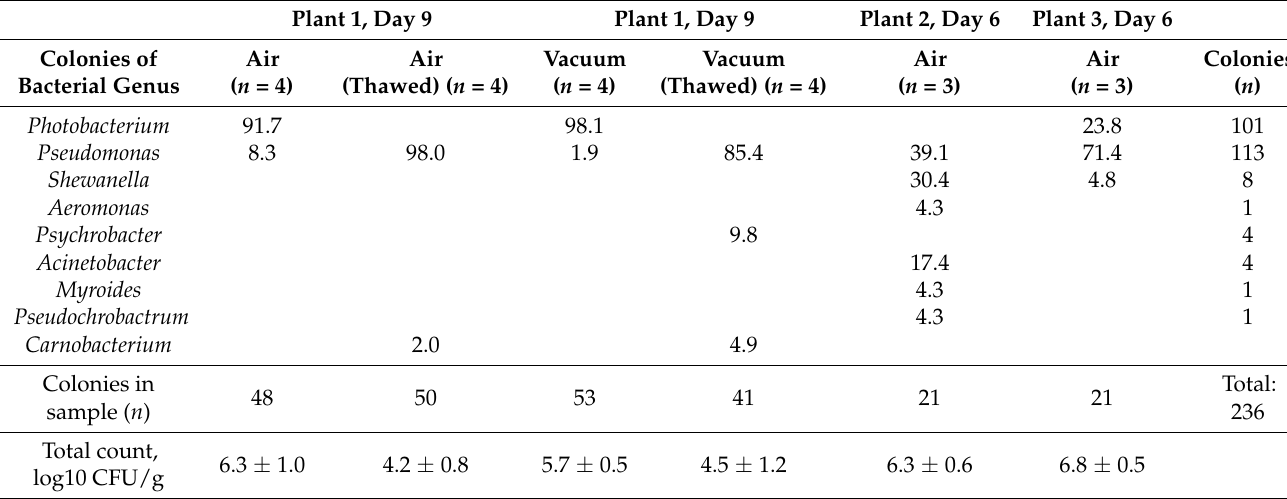
Table 2. Bacteria (%) characterized (by 16S rRNA gene sequencing of colonies) from the same samples of fish fillets ( n ) after 6 (industrial processing plants) and 9 days (controlled facility) of storage (3 ◦